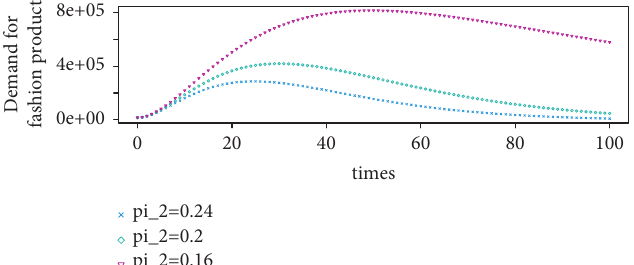
Figure 11: Simulation of the demand for fashion products at different rates of contact/interaction-based policy restrictions. This is aimed at decongesting the population, especially lockdowns, travelling restrictions, closure of schools, entertainment centers markets, band on social events, etc. The rate of interaction-based restriction π increases from 0.16 to 0.2 and finally, to 0.24, which is associated with an inward shift 2 in the demand curve for fashion